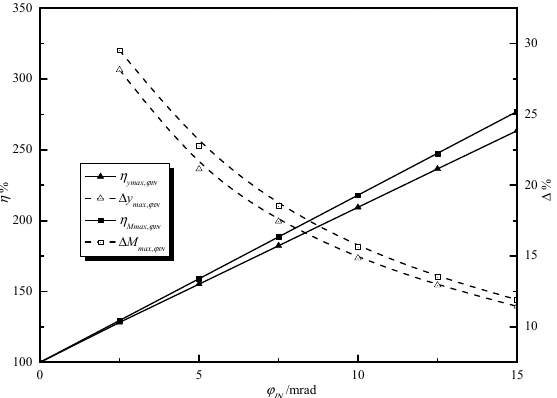
ϕ , η M max, ϕ and ∆ y max, ϕ , ∆ M max, ϕ along with ϕ IN . Figure 14. Change curve of along with ϕ IN . IN . IN IN IN IN